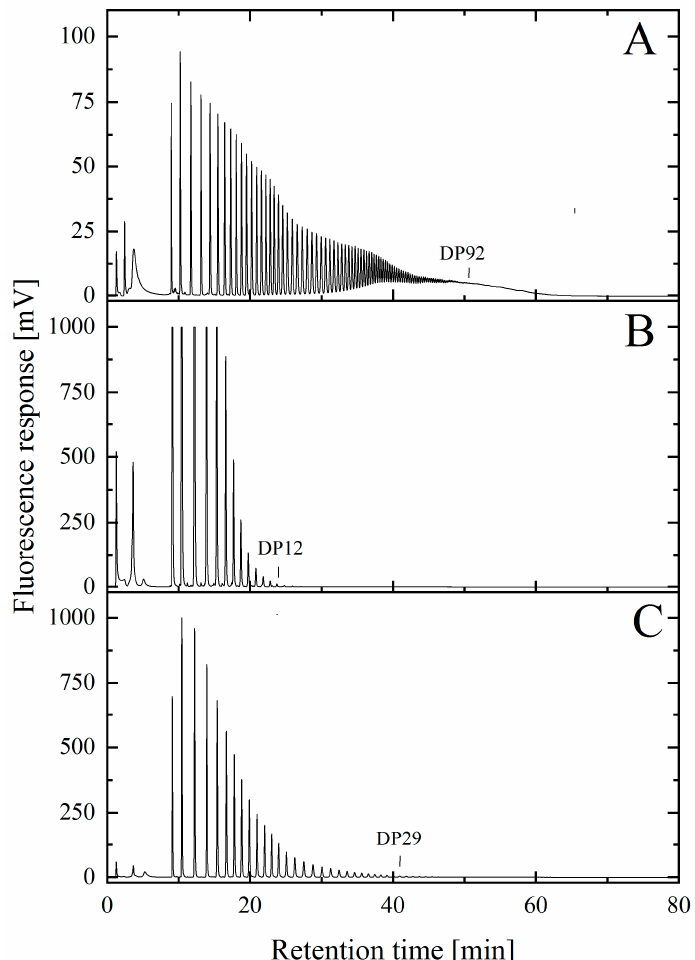
Figure 5. DMB-HPLC chromatograms of the isolated low-molecular-weight polySia after thermal hydrolysis. LC polySia ( A ) was incubated at 90 °C for 2 h. The hydrolyzed material was then collected via a three-stage gradient using an anion exchange (AEX) membrane adsorber. The first stage used 0.28 M ammonia bicarbonate for the elution of undesired short chain polySia molecules up to DP12 ( B ). The target fraction was eluted with 0.35 M ammonia bicarbonate and contained polySia with a chain length of DP29 ( C ).